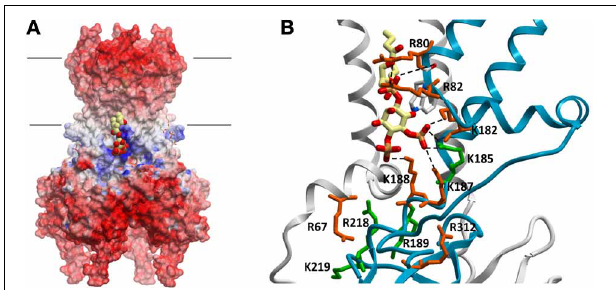
FIGURE 1 | (A) Electrostatic potential map of chicken Kir2.2 channels (PDB:3SPI). Large regions of negative potentials are present at the extracellular and intracellular surfaces, which are important for ion and inhibitor binding. A band of positively charged residues lie just below the lipid bilayer which (i) form critical interactions necessary to establish a three dimensional pocket for PIP lipids, and (ii) in the case of some of these residues, help to co-ordinate the ligands in the pocket. PI(4,5)P 2 molecules are shown in space-filling and stick representations in this binding pocket. (B) PI(4,5)P 2 (and likely all other PIPs) is coordinated by residues at the interface of 2 subunits. Postively charged residues thought to contribute to PIP 2 sensitivity are highlighted using Kir2.1 channel numbering. Despite their proximity and in some cases their involvement in co-ordinating the lipid, not all residues contribute to the energy of PIP 2 binding. Residues in green contribute to the energetics of binding, while residues in red appear to primarily affect gating transitions [adapted from Hansen et al.